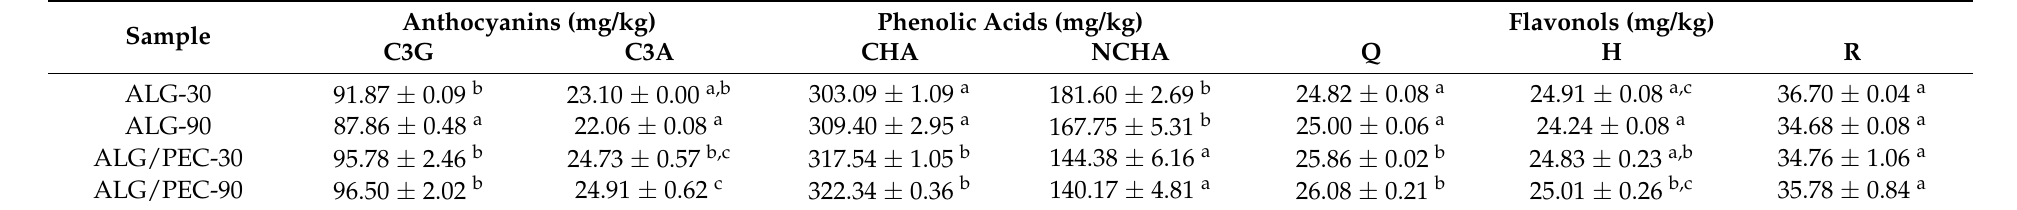
Table 3. Concentrations of individual polyphenols in hydrogel beads determined using the HPLC